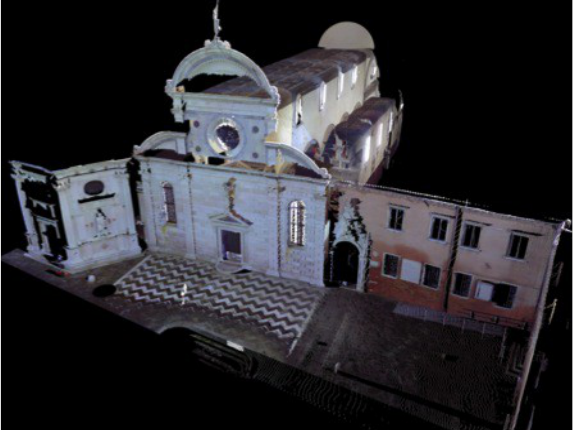
Figure 3 The laser scanning point cloud of the facade of San Michele in Isola